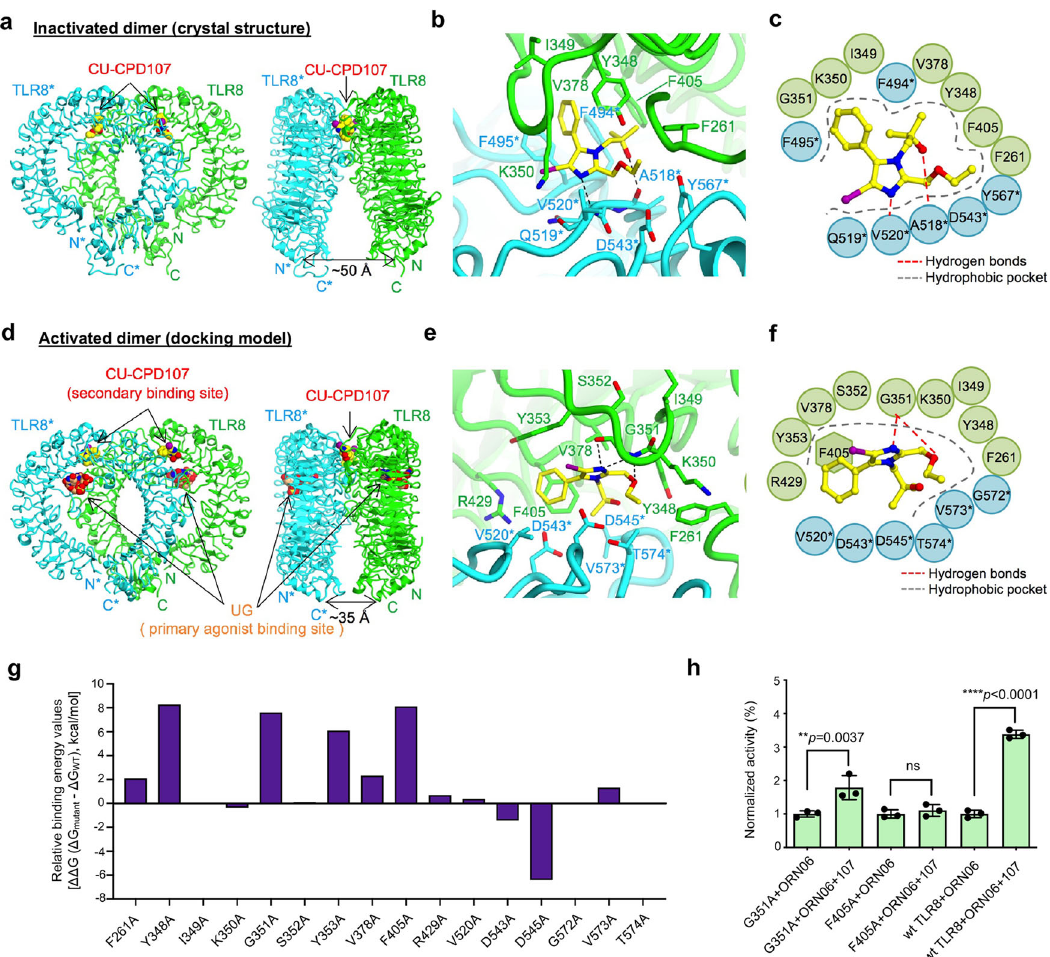
Fig. 4 Unexpected molecular mechanism of CU-CPD107. a Crystal structure of the TLR8/ CU-CPD107 complex (PDB: 7CRF). Front (left) and side (right) views of the complex. TLR8 and its dimerization partner, TLR8*, are colored green and cyan, respectively. The ligand molecules are illustrated by space- fi lling representations. The C, O, and N atoms of the ligands are colored yellow, red, and blue, respectively. b and c are the close-up views and schematic representation of interactions between CU-CPD107 and the TLR8 protein, respectively. The hydrophobic pocket and hydrogen bonds are shown as dashed gray arcs and dashed red lines, respectively. d Computational molecular modeling of CU-CPD107 docked to TLR8/ssRNA40 (PDB: 4R08) suggesting that the dimeric interface is the most likely target region for CU-CPD107 . e and f are the close-up views and schematic representation of interactions between the CU-CPD107 with TLR8/ssRNA40 complex. g In silico alanine scanning of the residues within the CU-CPD107 -binding site. The relative binding energy change ( ΔΔ G) of each mutant over the wild type was calculated using the Prime-MM/GBSA method. h Activities of CU-CPD107 in the mutants and wild- type hTLR8, stimulated by 5 μ g/mL ORN06. The NF- κ B induction fold of the mutants and wild-type TLR8 were analyzed by a SEAP assay using HEK-Blue Null1 cells. Data are mean ± s.d.; n = 3 independent experiments. A one-way analysis of variance with Bonferroni ’ s multiple comparisons test for multiple comparisons was used for statistical analysis. Statistical signi fi cance of the data is indicated as follows: * P < 0.05, ** P < 0.01, *** P < 0.001, **** P < 0.0001; ns not signi fi cant. Source data are provided as a Source data fi